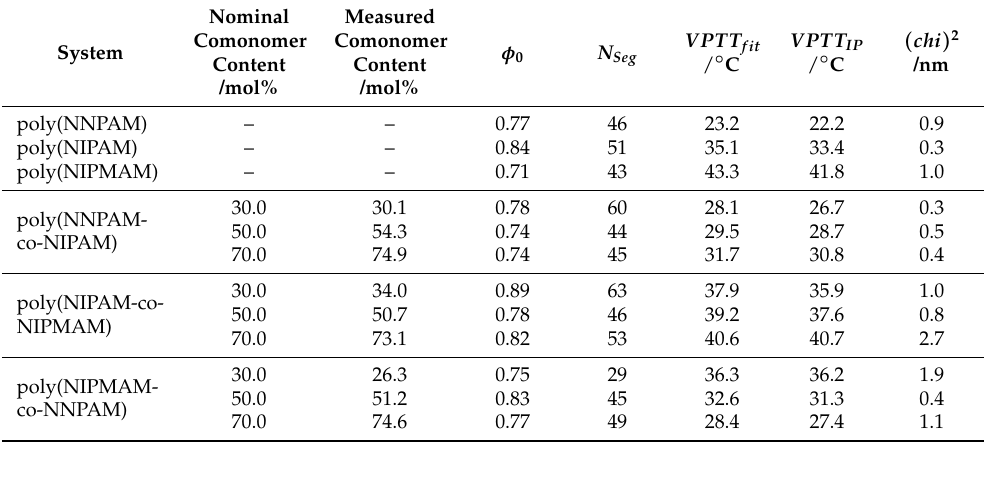
Table 1. Parameters resulting from the fit of the presented swelling curves and the corresponding ( chi ) 2 -values of the fits and the volume phase transition temperature ( VPTT inflection point of the R H ( t ) –swelling curve.